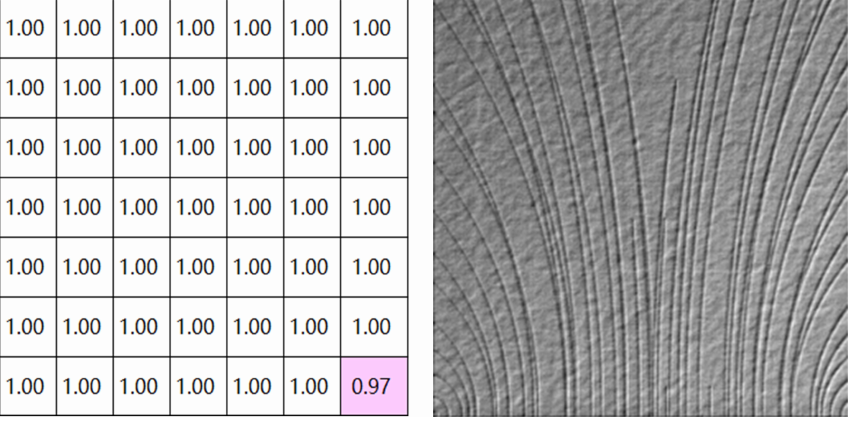
Figure 10. A non-defective image ( right ) and its probability matrix ( left ). The number in the box indicates the probability that the patch is